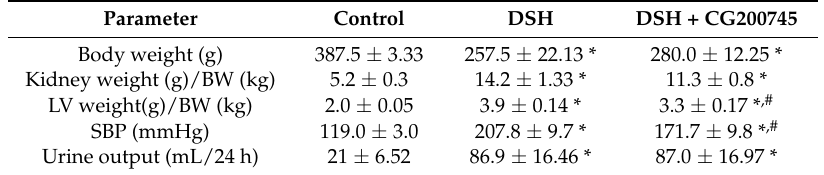
Table 1. Blood pressure and organ weights among experimental groups of rats.